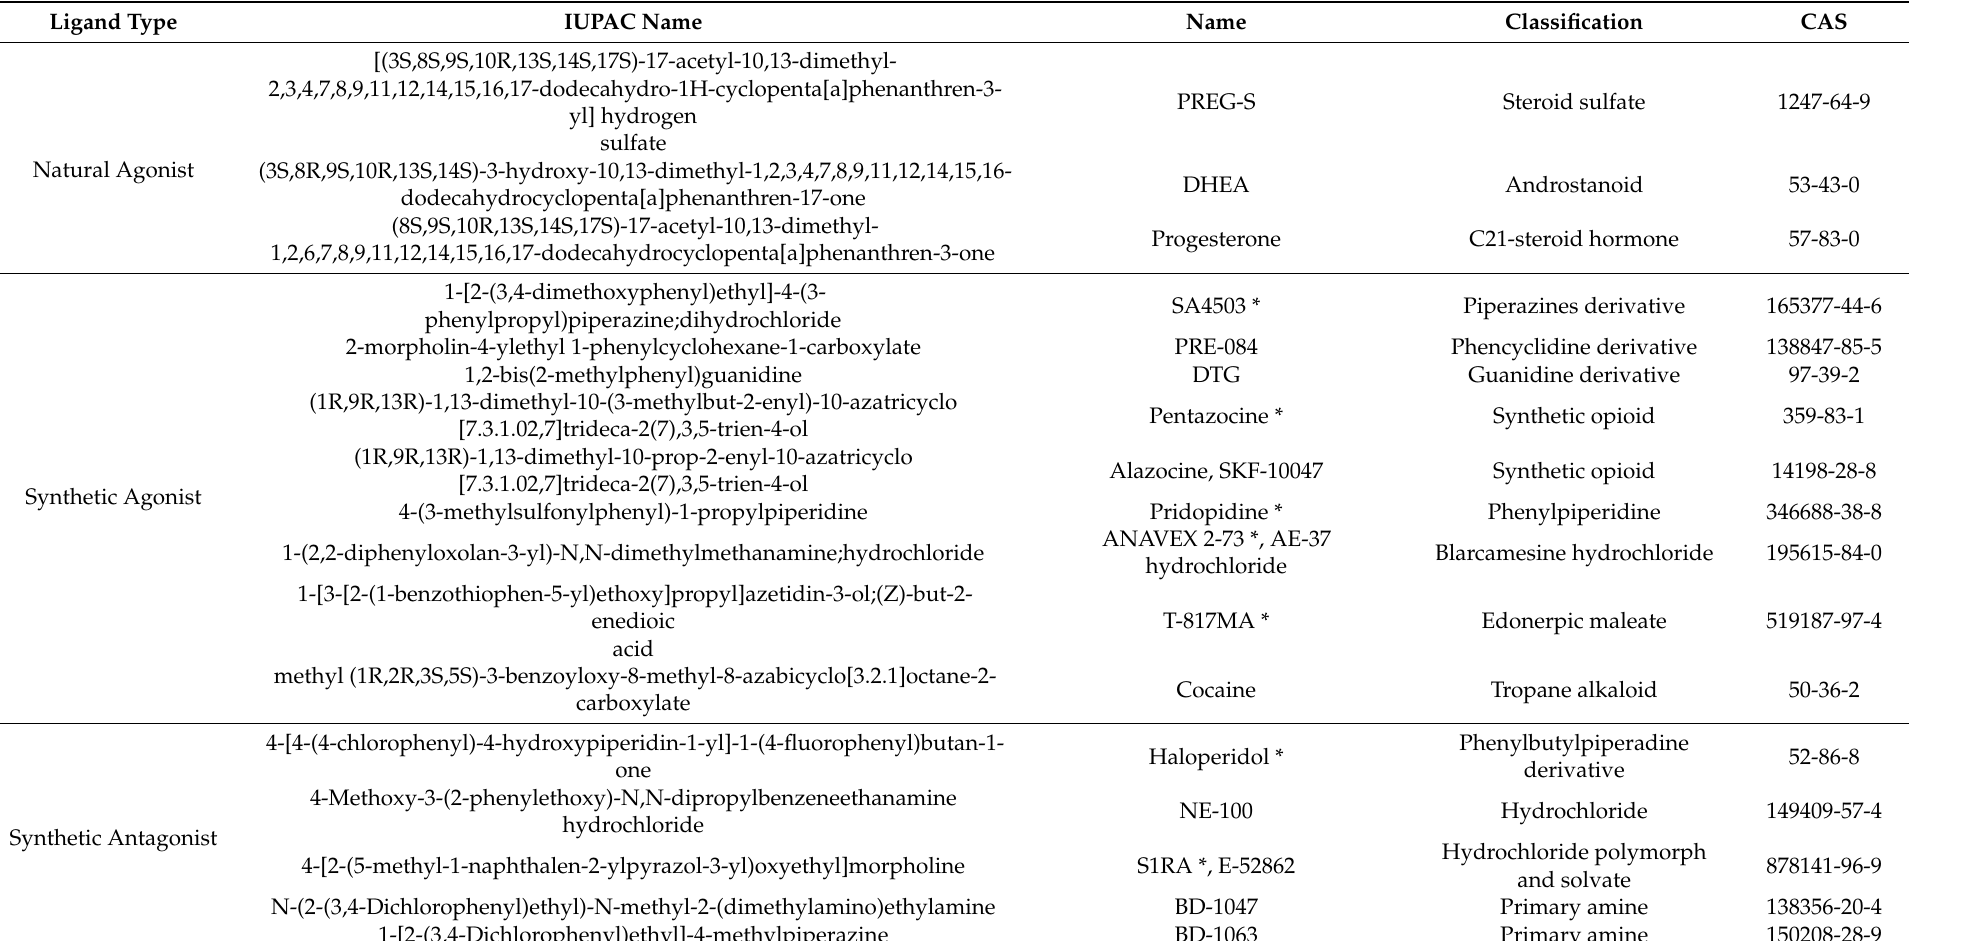
Table 1. Types of Sig-1R ligands and their